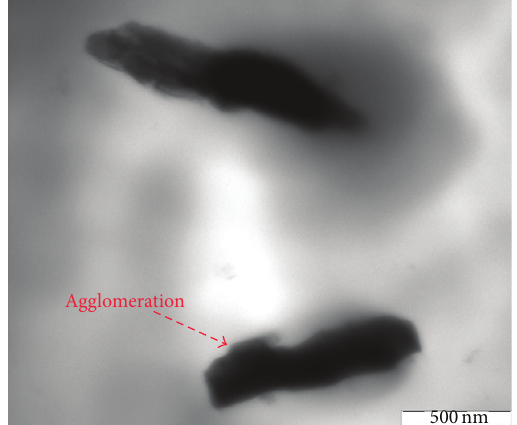
Figure 15: TEM observation of cryothin sectioning for PP/5% nano 𝛼 -Al 2 O 3 composites without